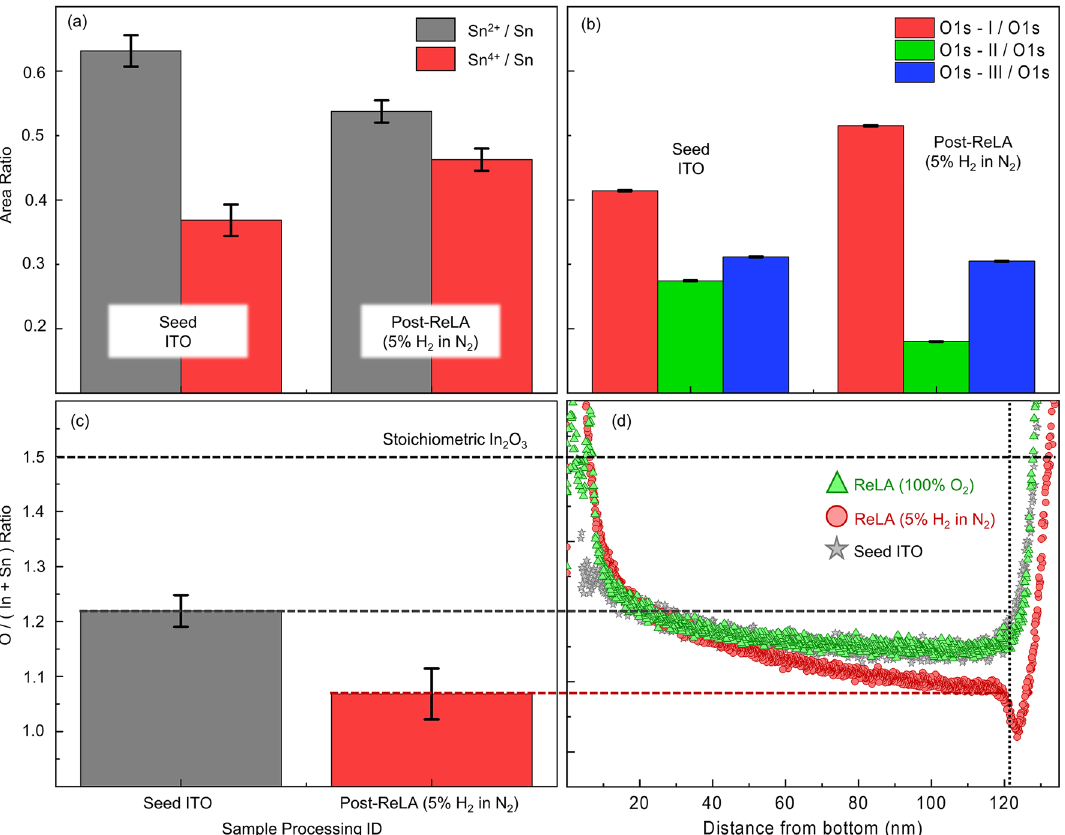
Figure 4. Compositional properties of seed ITO films and laser processed at 125 mJcm − 2 . ( a,b ) Relative areal intensities of the deconvoluted component peaks of the core level X-ray photoelectron spectra for Sn:Sn 2+ (grey bar) and Sn 4+ (red bar) and O1s peaks: O I (red bar), O II (green bar) and O III (blue bar), respectively, for the seed ITO film and that subject to a single ReLA pulse at 125 mJcm − 2 in 5% H 2 in N 2 . ( c ) The O /( In + Sn ) ratio for the seed ITO film (grey bar) and that subject to a single ReLA pulse at 125 mJcm − 2 in 5% H 2 in N 2 (red bar), calculated from surface-XPS results. ( d ) Depth profile of O /( In + Sn ) for the seed ITO film (grey stars) and those subject to single ReLA pulse at 125 mJcm − 2 in 5% H 2 in N 2 (red circles) and 100% O 2 (green triangles), as calculated from EDX imaging. O /( In + Sn ) for a stoichiometric In 2 O 3 film is indicated by the black dashed line. We map the XPS results onto the “surface” (black vertical dotted line) of the EDX depth profile with the horizontal grey and red dashed